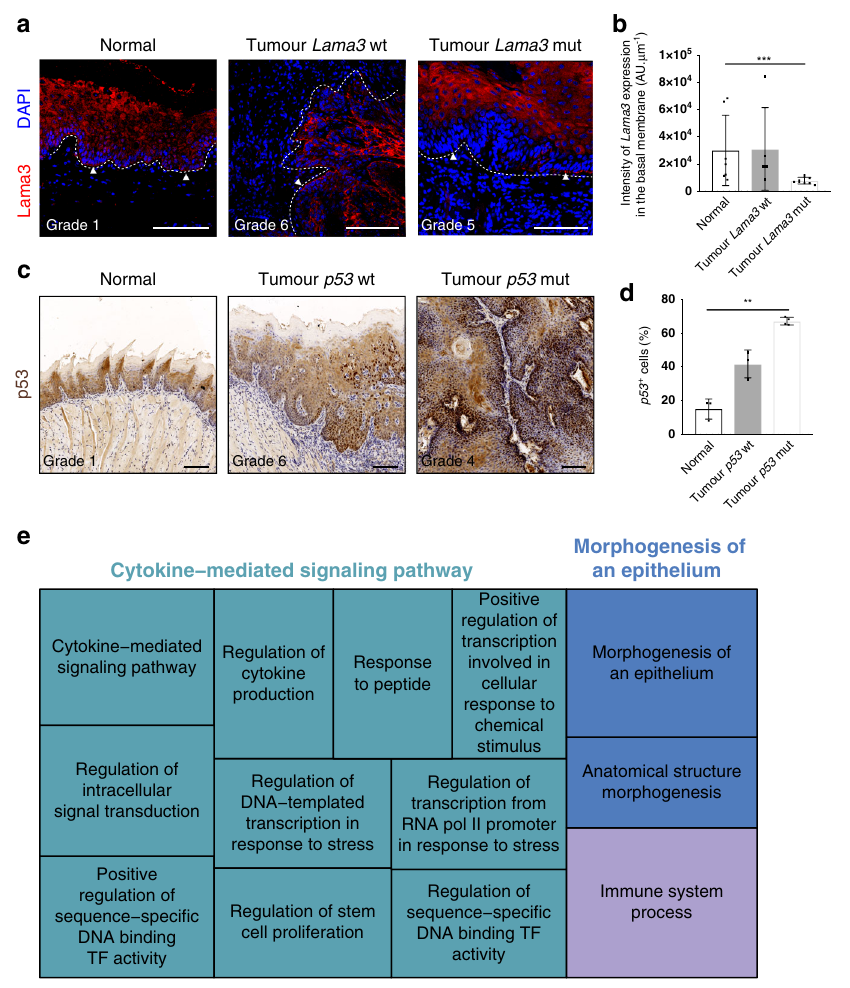
Fig. 3 Expression of Laminin α 3 and p53 in mutated tumours. a , c Representative images of immunostaining of Laminin α 3 ( a ) and p53 ( c ) in normal tissue, wild-type and mutated tumours. Arrowheads indicate areas with loss of Laminin α 3 expression in mutated tumours ( n = 6 lesions mutated for Laminin α 3 ). Samples were counterstained with nuclear dye DAPI (4 ′ ,6-diamidino-2-phenylindole) ( a ) or with haematoxylin ( c ). Dotted line delineates basement membrane. Scale bars, 100 µ m. b Quanti fi cation of the expression of Laminin α 3 in the basement membrane ( n = 3 normal samples with n = 7 regions of interest (ROIs) quanti fi ed, n = 3 tumour Lama3 wt samples with n = 5 ROIs quanti fi ed, n = 4 tumour Lama3 mutated samples with n = 9 ROIs quanti fi ed). d Quanti fi cation of p53 positive cells ( n = 3 normal, 3 tumour p53 wt samples, 4 tumour p53 mutated samples). Bar graphs represent mean ± SD, ** p ≤ 0.05, *** p ≤ 0.001, p = 0.0014 for p53 , p = 0.0010 for Laminin α 3 , one-way ANOVA, Kruskal – Wallis test. e Gene Ontology analysis of driver genes. Each rectangle is a single cluster representative of GO categories (biological processes), joined together into three main categories (superclusters): cytokine- mediated signalling pathway, morphogenesis of an epithelium and immune system process. Size of the rectangles is adjusted to re fl ect the frequency of the GO term in the underlying GO analysis